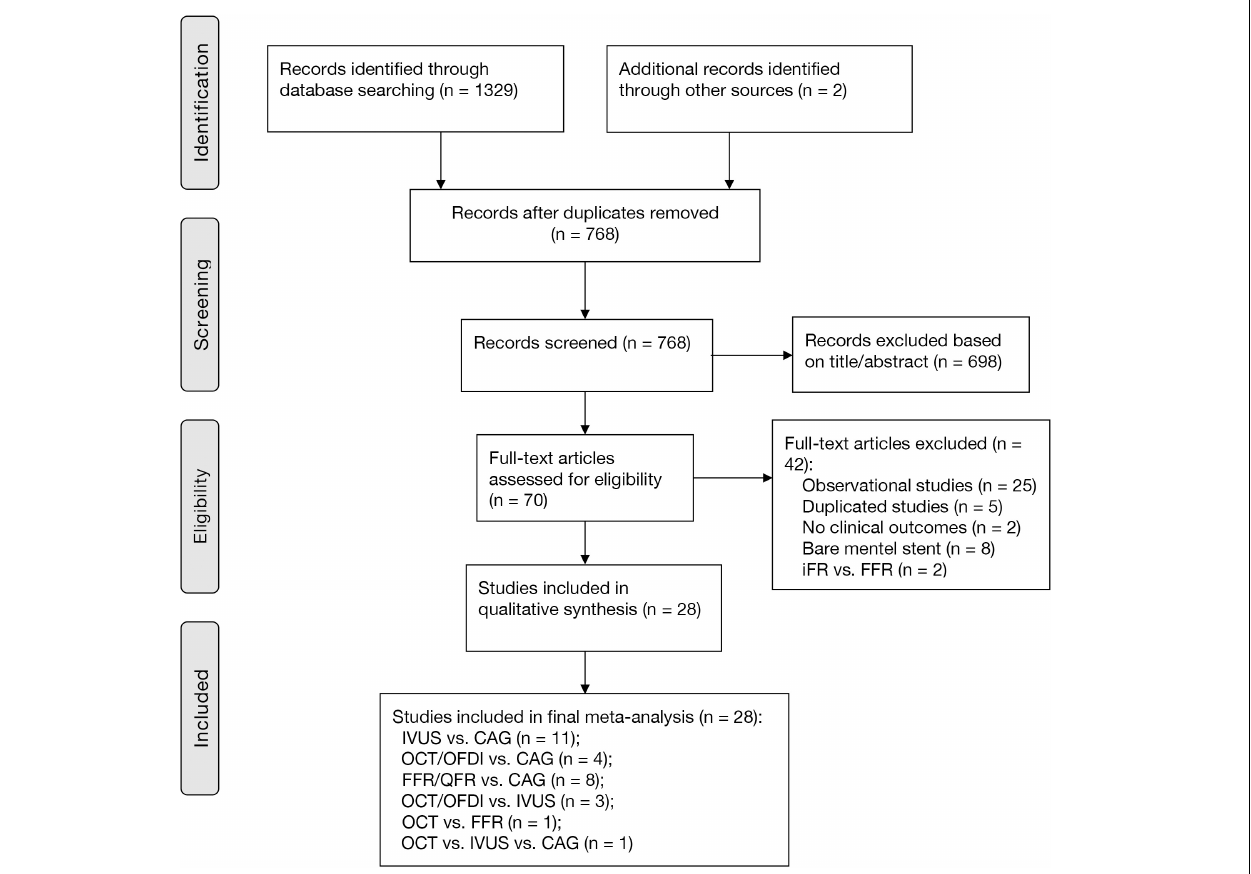
FIGURE 1 | PRISMA diagram for study inclusion. CAG, coronary angiography; FFR, fractional flow reserve; IVUS, intravascular ultrasound; OCT, optical coherence tomography; OFDI, optical frequency domain imaging; QFR, quantitative flow